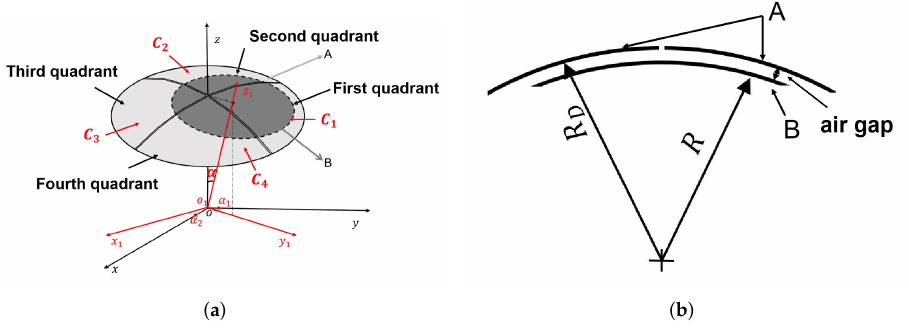
Figure 1. The 2-DOF angular displacement calculation model: ( a ) The schematic of the spherical capacitive sensor, ( b ) The schematic diagram of the cross-sectional of the spherical capacitive